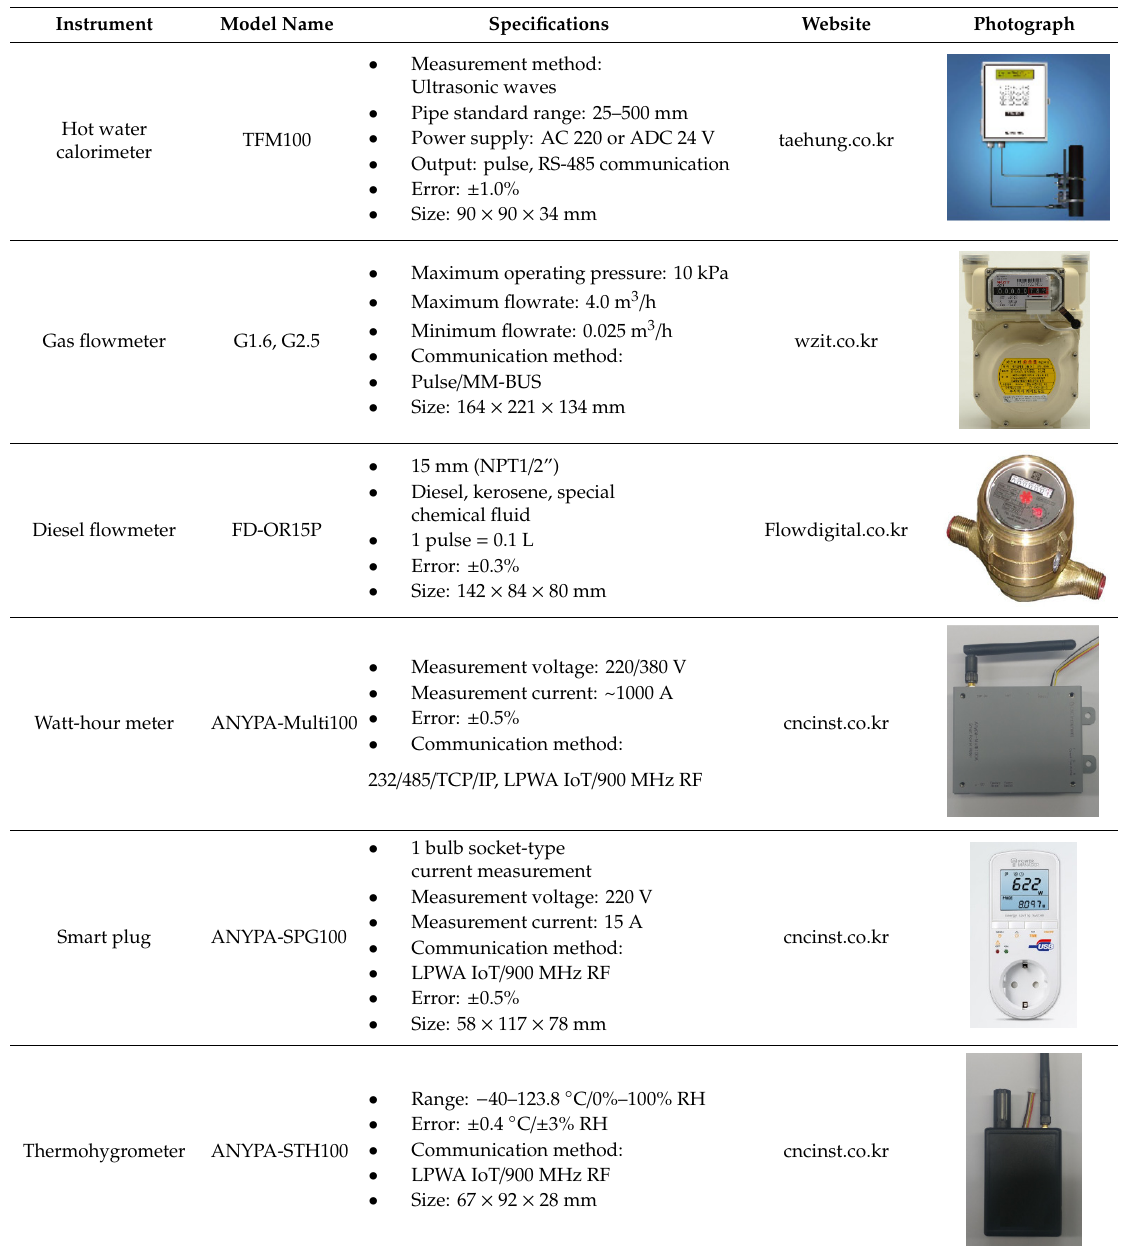
Table A4. Details of the measurement instruments.